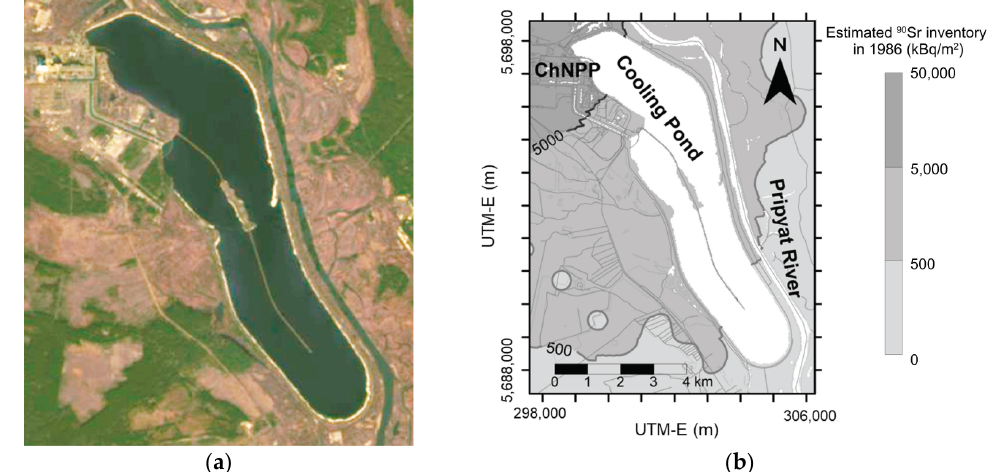
Figure 1. Satellite image of the CP in 2014 before water level drawdown ( a ) and the schematic map of the density of 90 Sr deposition in 1986 at the CP ( b ).